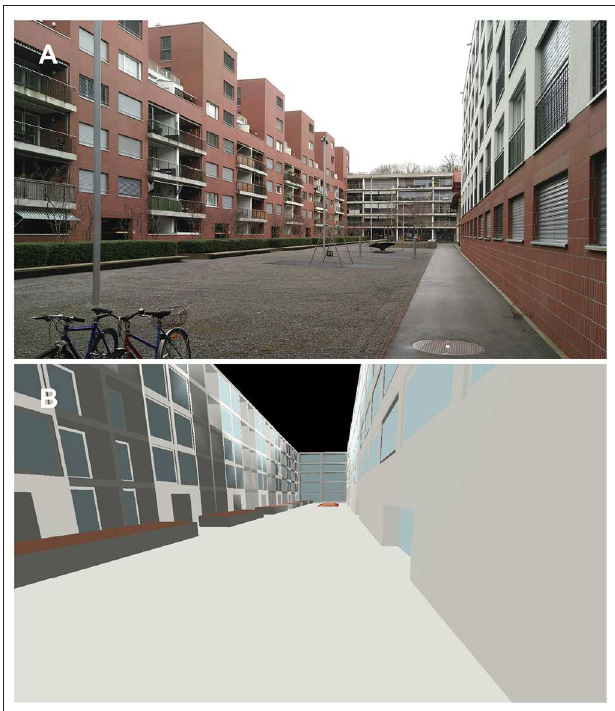
FIGURE 4 | The reference inner yard: (A) the building complex and (B) its ODEON